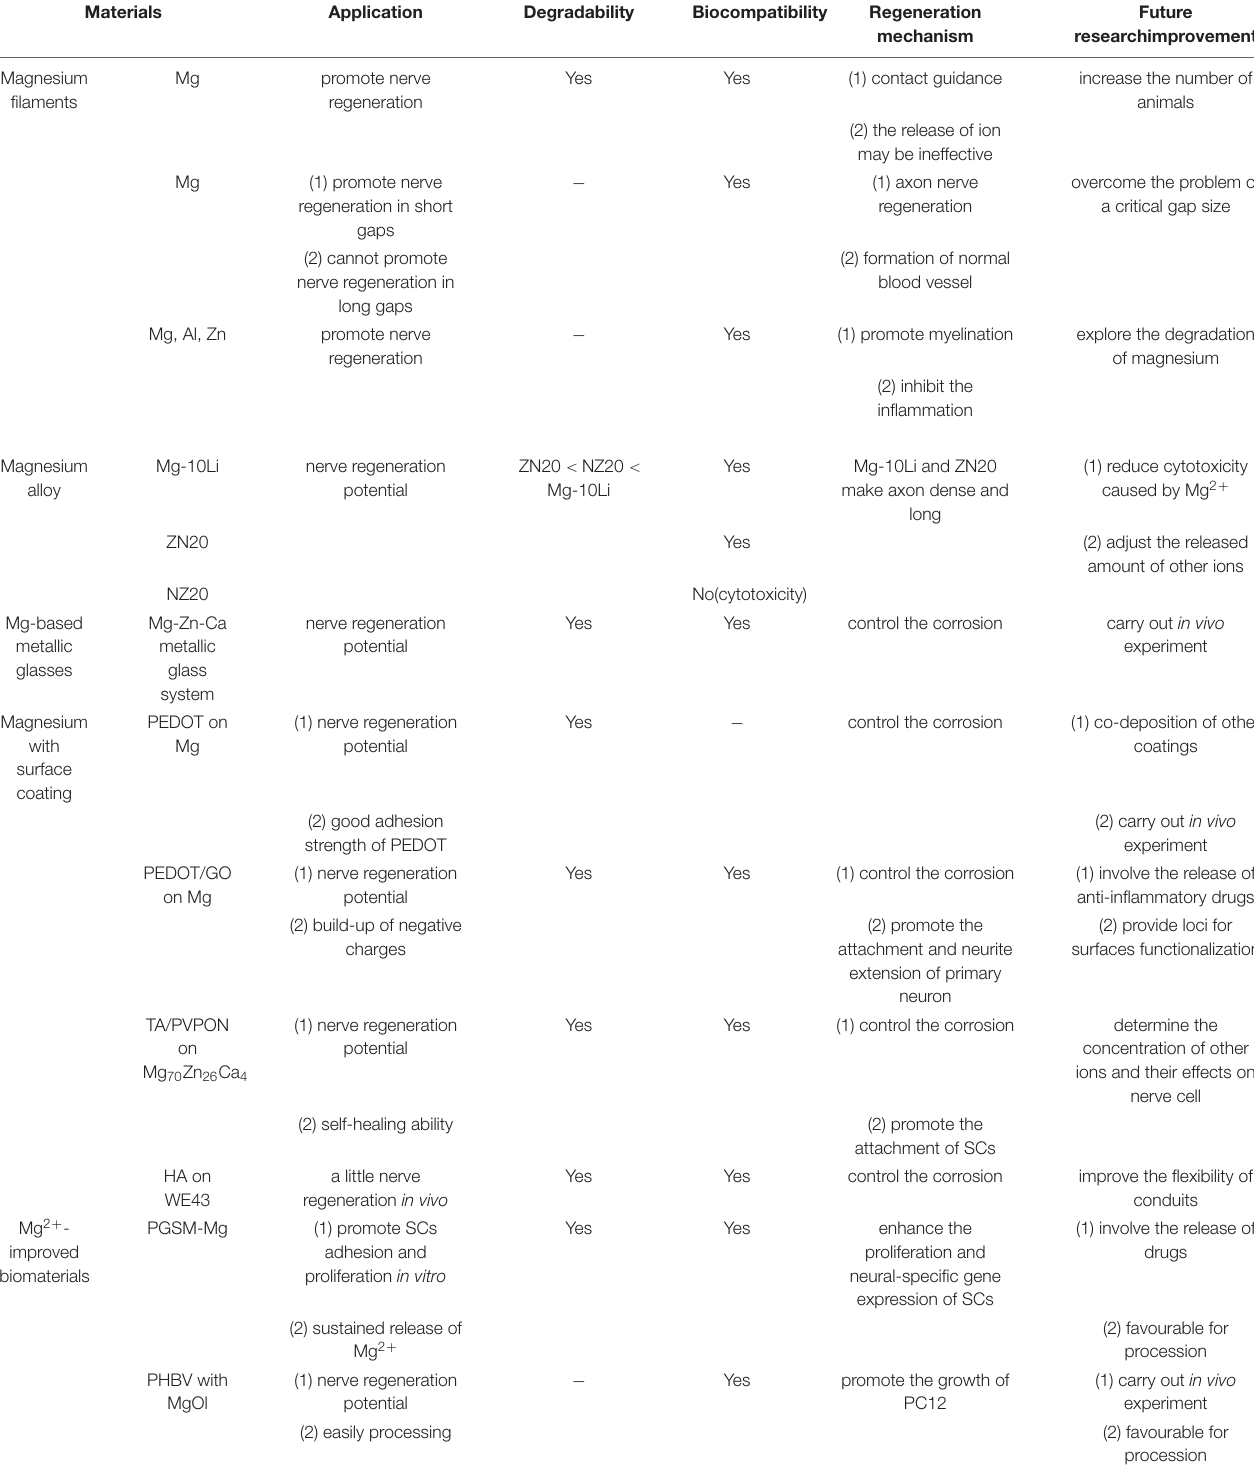
TABLE 2 | Magnesium promotes the regeneration of the peripheral